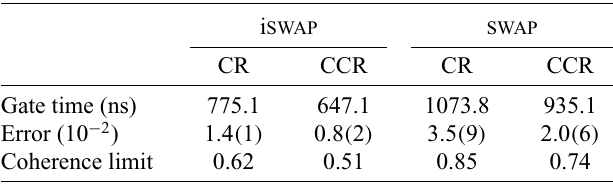
TABLE II. Comparison of performance of i SWAP and SWAP gates implemented with CR and CCR